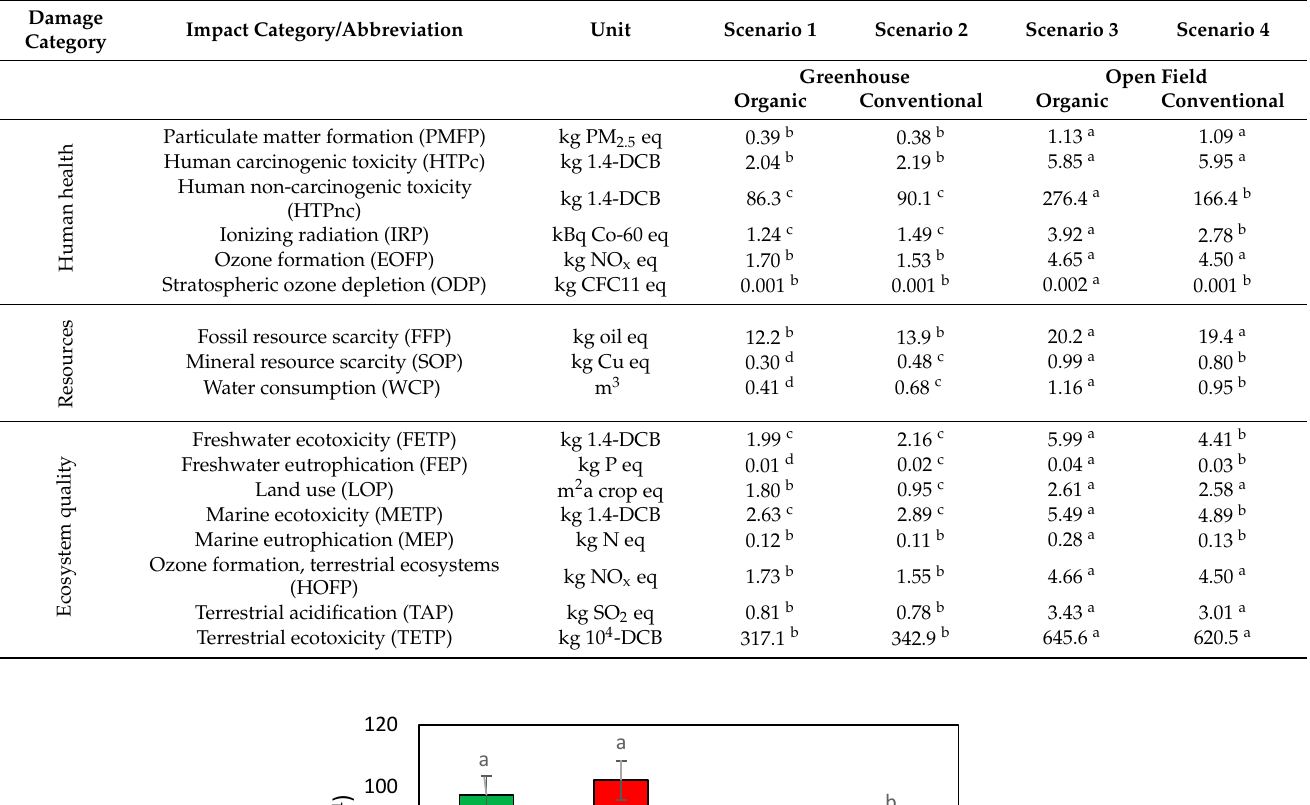
Table 4. Midpoint environmental impact assessment (1-ton yield) of organic and conventional tomato production in the open field and greenhouse based on 1 ton. Different lower cases indicate significant differences.